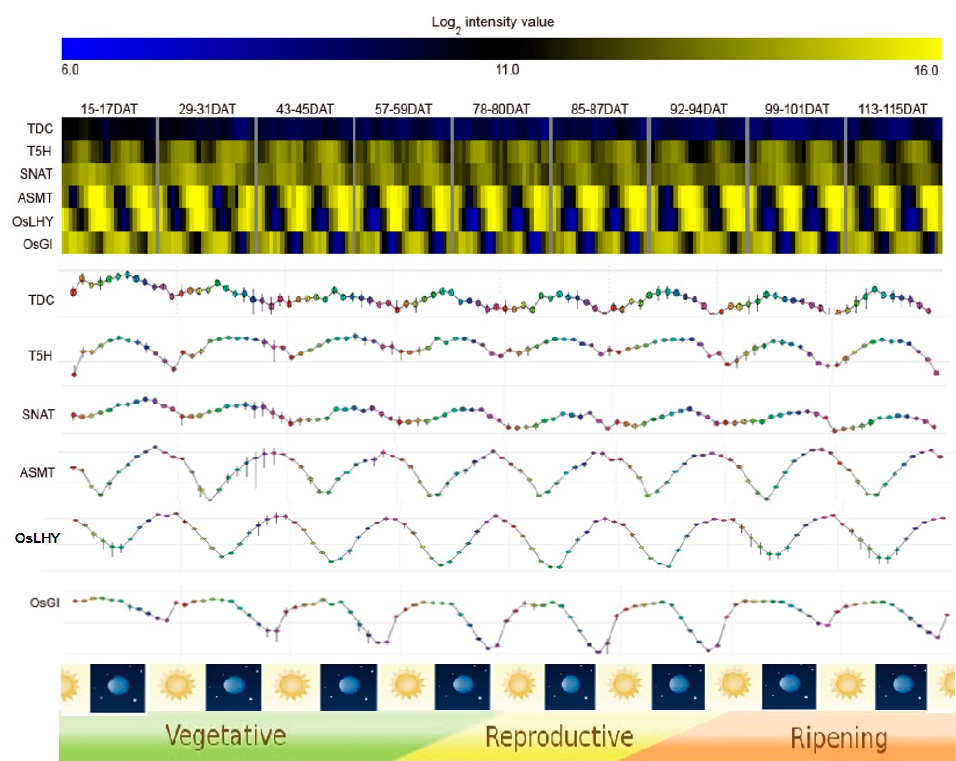
Figure 2. The meta-expression analysis of genes in each step of the rice melatonin biosynthetic pathway and confirmation of the expression patterns from RiceXPro. As standard marker genes for diurnal rhythm, the expression of OsLHY peaked during daytime and the expression of OsGI peaked at the start of the nighttime. TDC —LOC_Os07g25590; T5H —LOC_Os06g43430; SNAT —LOC_Os05g44020; ASMT —LOC_Os07g28040. DAT—days after transplanting.